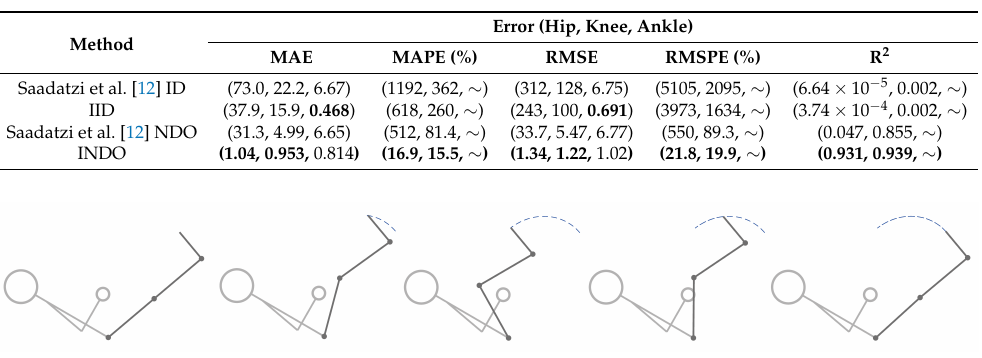
Table 3. Human–robot interaction torque estimation methods performance indices during a squat ex- ercise with SNR = 40dB and 20% BSIPs uncertainties. Bold numbers highlight the best metric value.